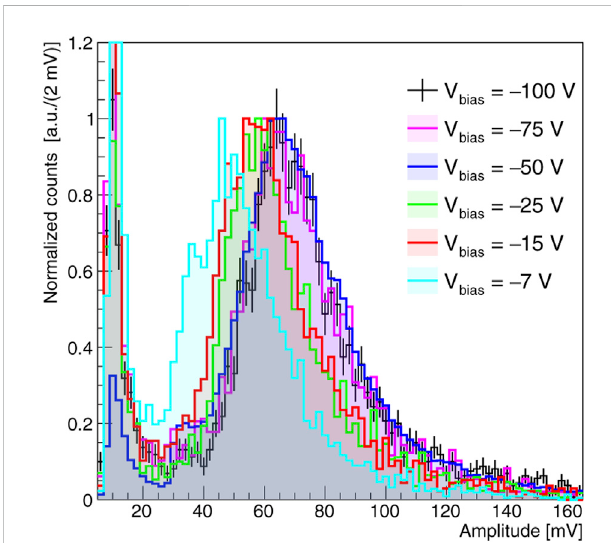
FIGURE 11 Amplitude distribution of the single pixel at normal beam incidence and for different bias voltages. The distributions are normalized at the Landau